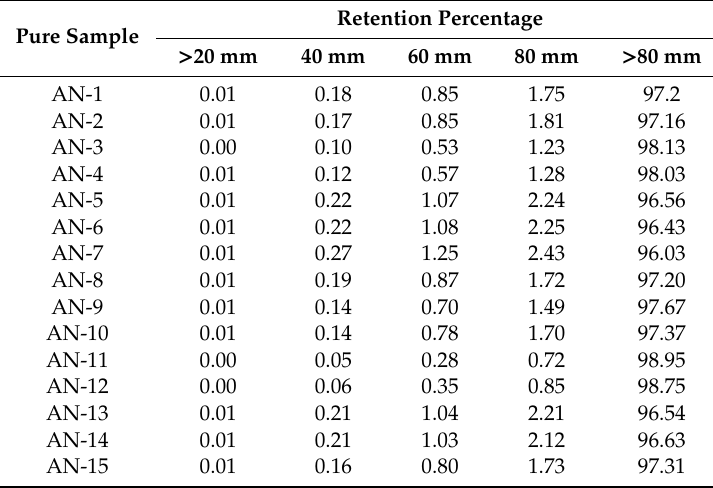
Table 2. Particle size distribution by